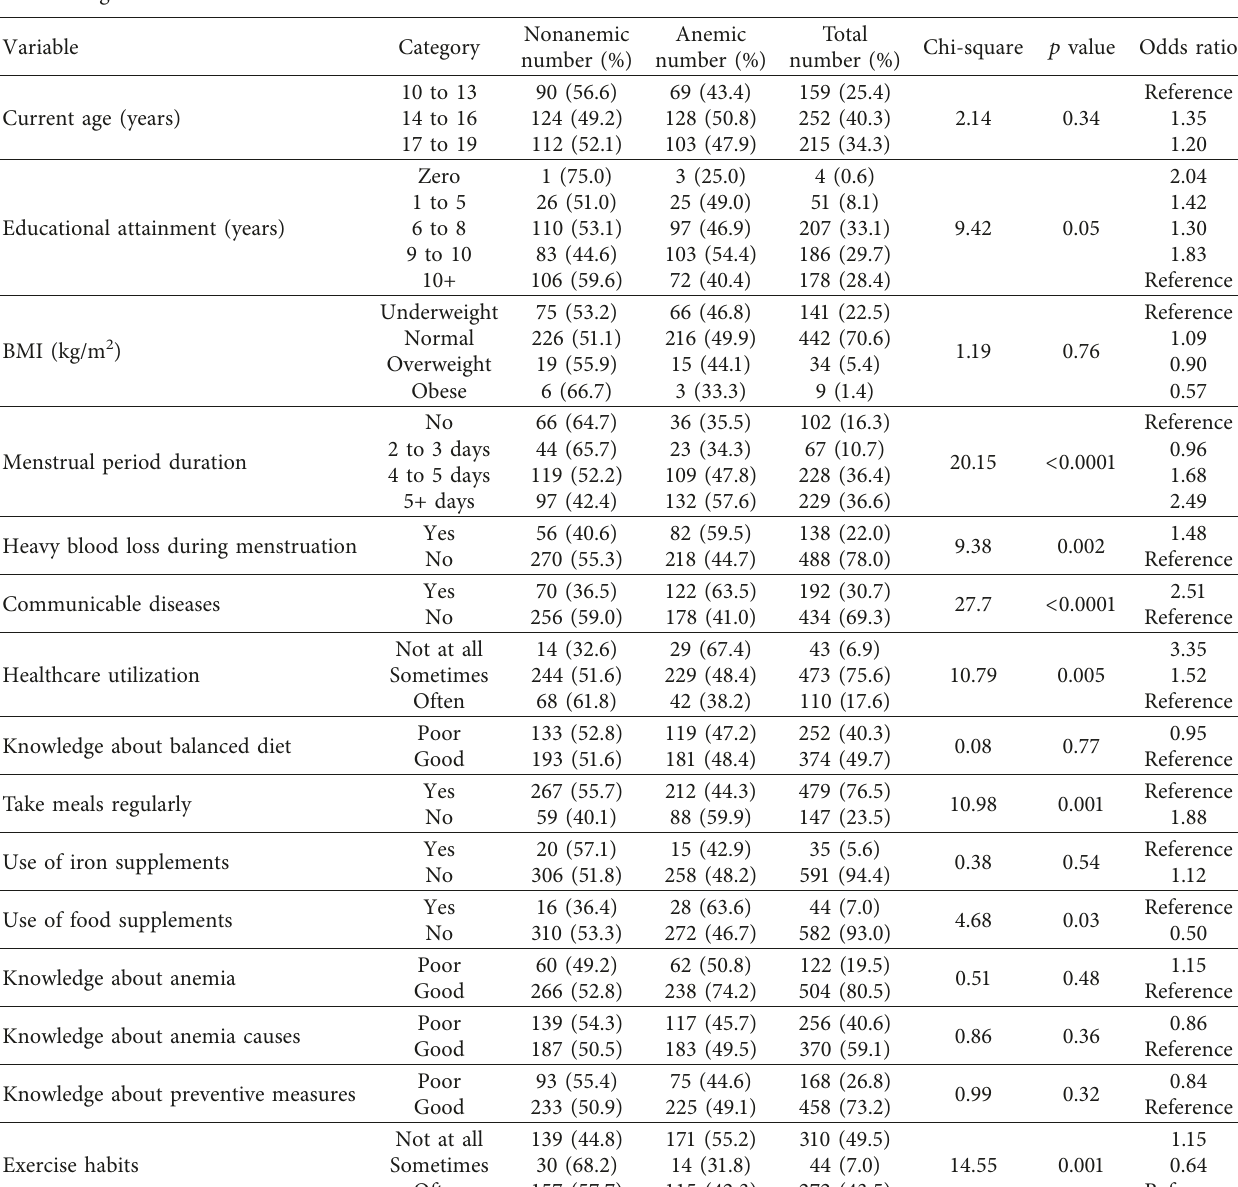
Table 2: Descriptive and bivariate analyses to reveal the individual characteristics and their association with prevalence of anemia among adolescent girls.